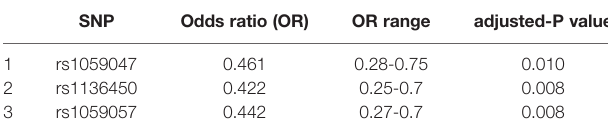
TABLE 3 | IPF association with SFTPA1 single SNPs.